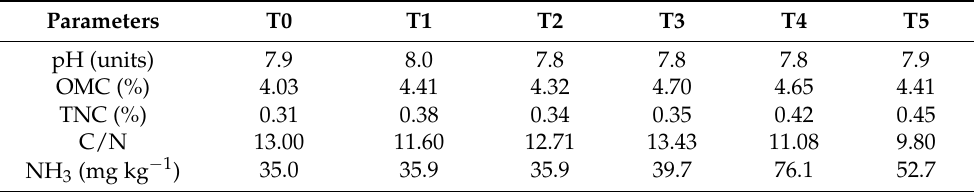
Table 2. Effects of biofertilization on Coriander sativum . Soil properties.